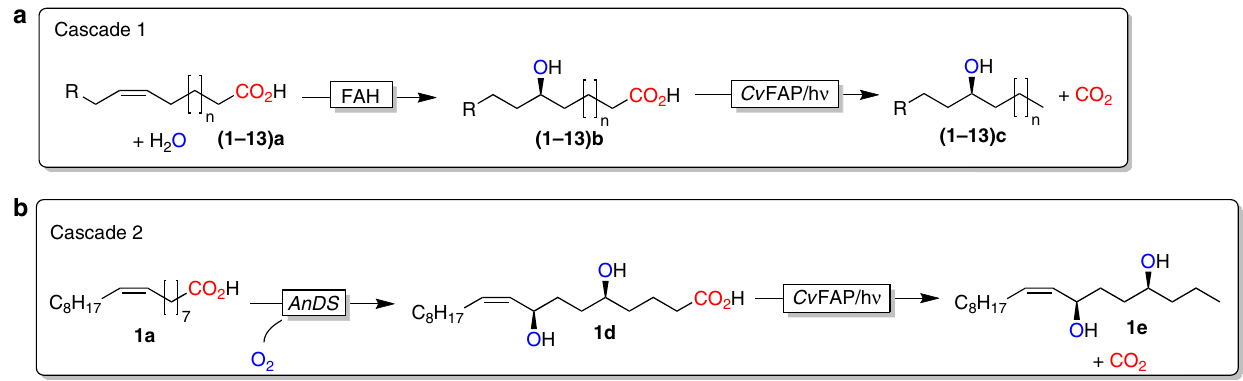
Fig. 2 Proposed photoenzymatic cascades to transform unsaturated fatty acids into secondary alcohols. a Cascade 1 comprises the (stereoselective) addition of water to C = C-double bonds catalysed by fatty acid hydratases (FAHs) followed by the decarboxylation mediated by the photoactivated decarboxylase from Chlorella variabilis NC64A ( Cv FAP) generating secondary long-chain alcohols; b cascade 2 combines 5,8-diol synthase from Aspergillus nidulans ( An DS) with Cv FAP